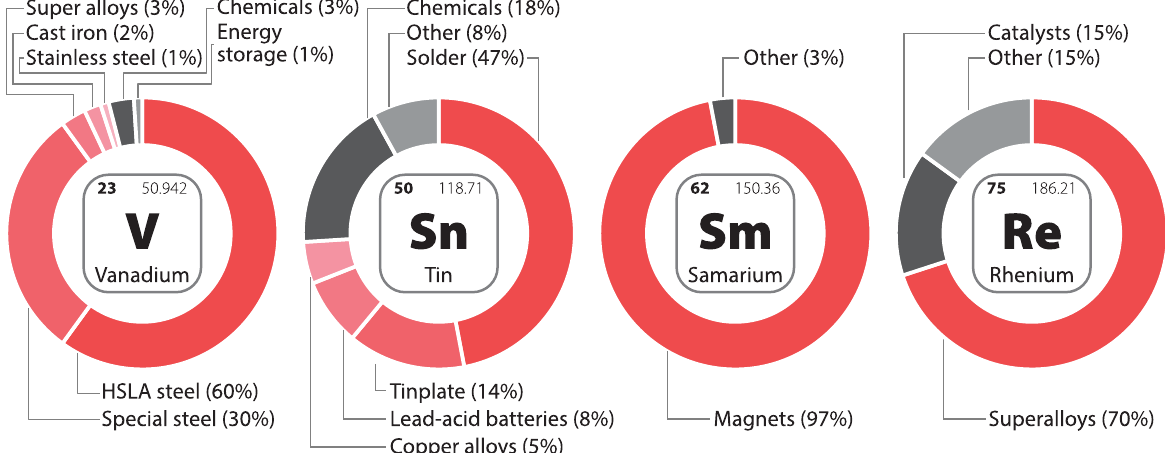
Fig. 3 Final uses of vanadium, tin, samarium, and rhenium circa 2020. Shades of red indicate the use in alloy